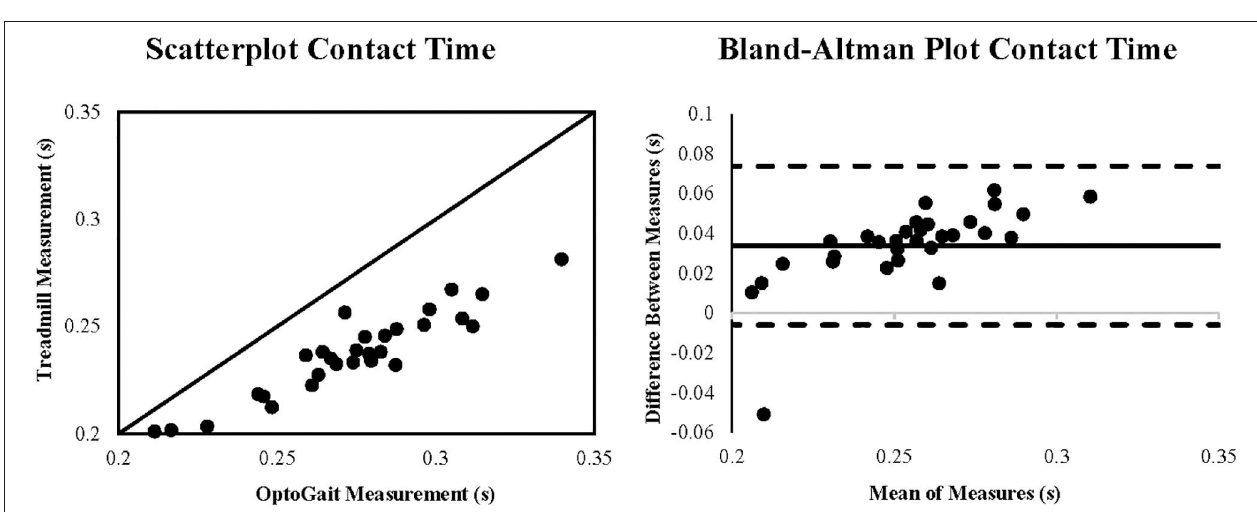
FIGURE 3 | Scatterplot and Bland-Altman plot for the measurement of contact time (seconds) during running for the OptoGait vs. instrumented treadmill. The Bland-Altman plot includes the bias (solid black line) and the upper and lower 95% limits of agreement (dashed